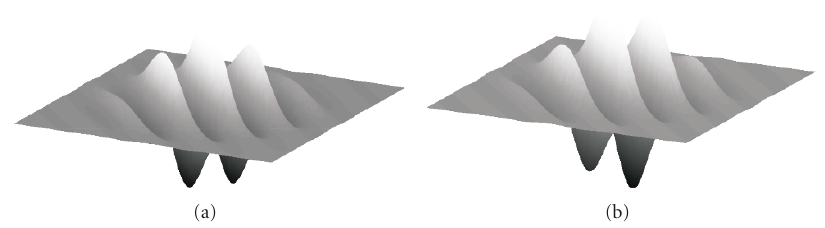
Figure 1: An example of the real (a) and imaginary (b) part of a Gabor filter.